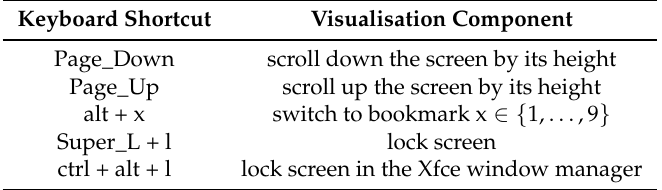
Table 1. Mapping of exemplary keyboard shortcuts to the NCP visualisation component